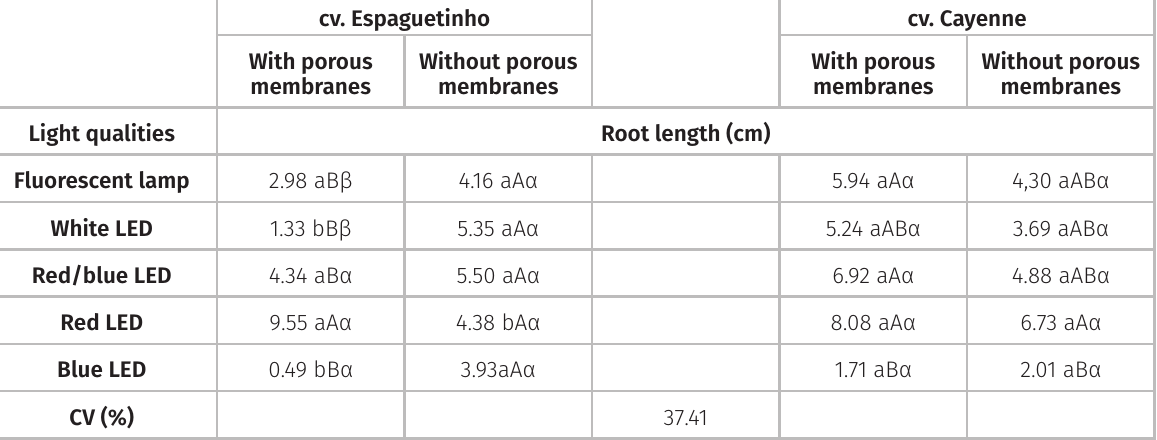
Figure 5. Growth variables of Capsicum frutescens cv. Cayenne and Espaguetinho cultivated under different light qualities and types of sealing. Number of nodal segments for the factor light qualities (a) and for the interaction types of sealing and cultivars (b) ; and shoot length for the light qualities factor (c) . * Lowercase letters for light quality do not differ by Tukey’s test, 5% level (a-c); Lowercase letters in the same type of sealing (with or without membranes) do not differ the cultivars between them, and uppercase letters in each cultivar do not differ for the type of sealing, by Tukey’s test, 5% level